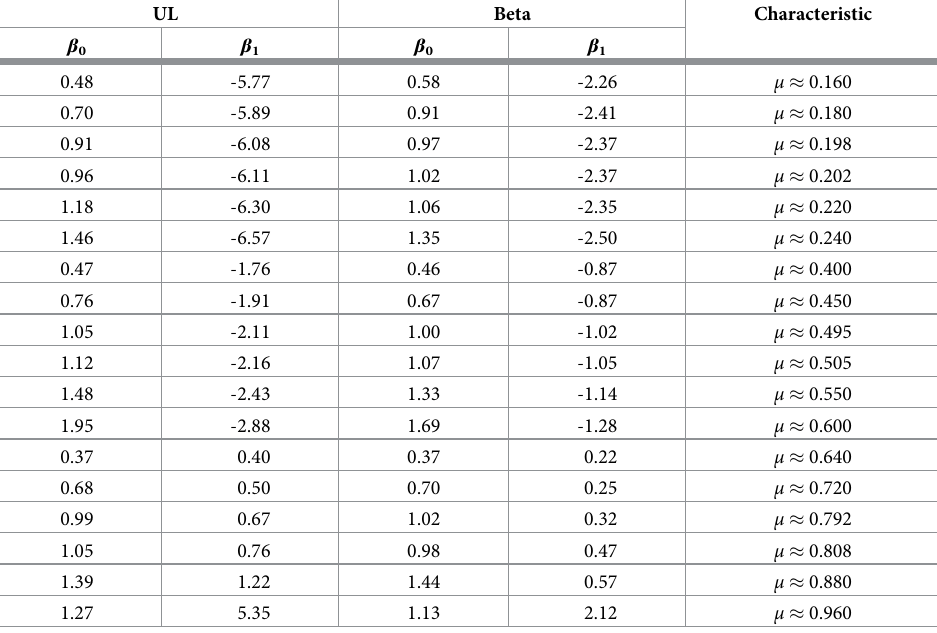
Table 3. Parameter values for scenarios considered in the simulation (out-of-control condition). UL